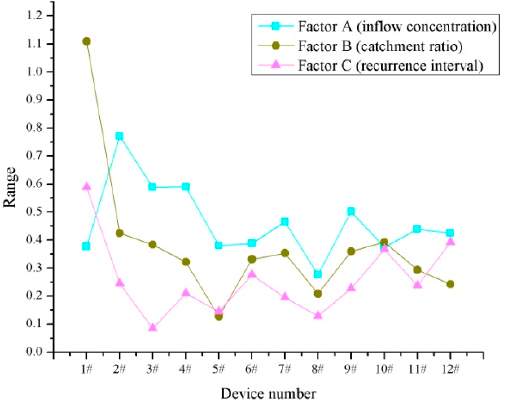
Figure 5. Comparison of range among the three factors.